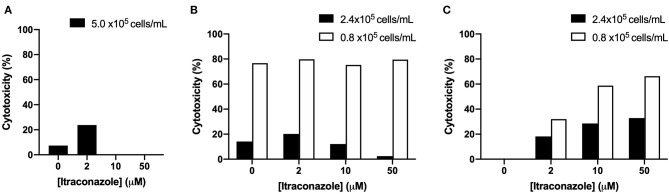
Percent cytotoxicity of hepatocytes treated with ITZ for 4 h and viability detected using (A) calcein AM, (B) MTT, or (C) neutral red.